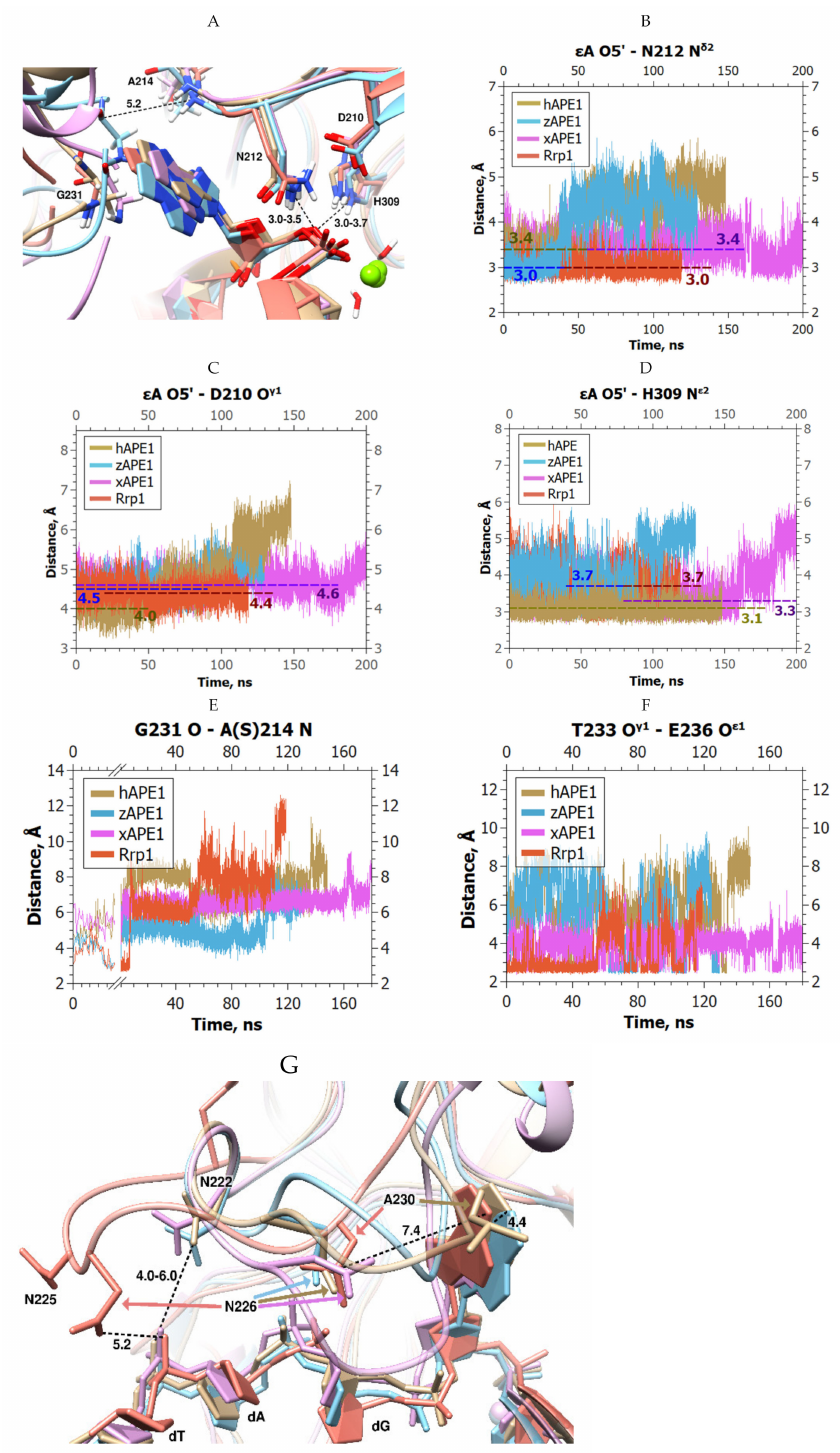
Figure 9. MD trajectories and structures of the complexes of APE1-like endonucleases with ε A- containing DNA (hAPE1 is sand-colored, zAPE1 is cyan, xAPE1 is magenta, and Rrp1 is red): ( A ) Structural models of enzyme–substrate complexes and average lengths of H-bonds. The average lengths of H-bonds His309 N ε 2 – ε A O5 (cid:48) and Asn212 N δ 2 – ε A O5 (cid:48) are indicated. The Gly231 O–Ala214 N distance was at least 5.2 Å among the four models; changes in ( B ) α A O5 (cid:48) –Asn212 N δ 2 , ( C ) α A O5 (cid:48) –Asp210 O δ 1 , ( D ) α A O5 (cid:48) –His309 N ε 2 , ( E ) Gly231 O–Ala214 N, and ( F ) Thr233 O γ 1 –Glu236 O ε 1 distances throughout the MD trajectories of the investigated APE1-like enzymes in complex with ε A-containing DNA; ( G ) the structure of the Asn222–Ala230 loop in the models involving ε